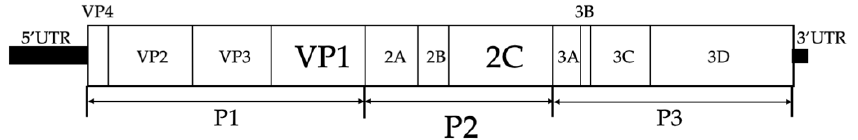
Figure 3. Structure of the enterovirus genome. The genome contains a single open reading frame that encodes a polyprotein and is flanked by 5′ and 3′ untranslated regions (UTRs). The encoded polyprotein contains three major regions (P1, P2, and P3). These regions can self-digest into four separate structural proteins (VP1, VP2, VP3, and VP4 from P1) and seven nonstructural proteins